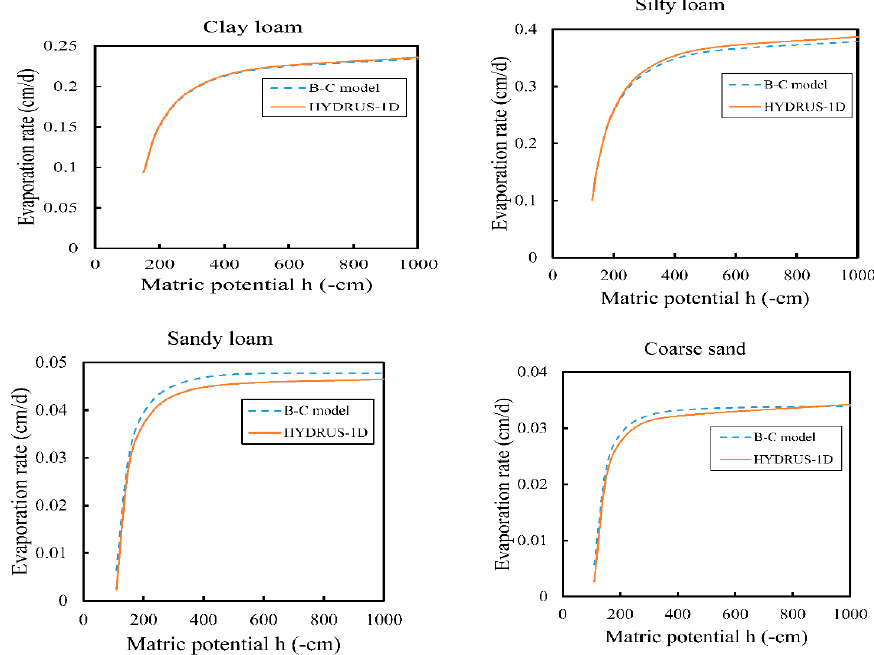
Figure 3. A comparison of the semi-analytical solutions (solid line) calculated with Equations (18)–(20) using the Brooks–Corey model and the results of HYDRUS-1D simulation (dashed-line) for four soils in Table 4.